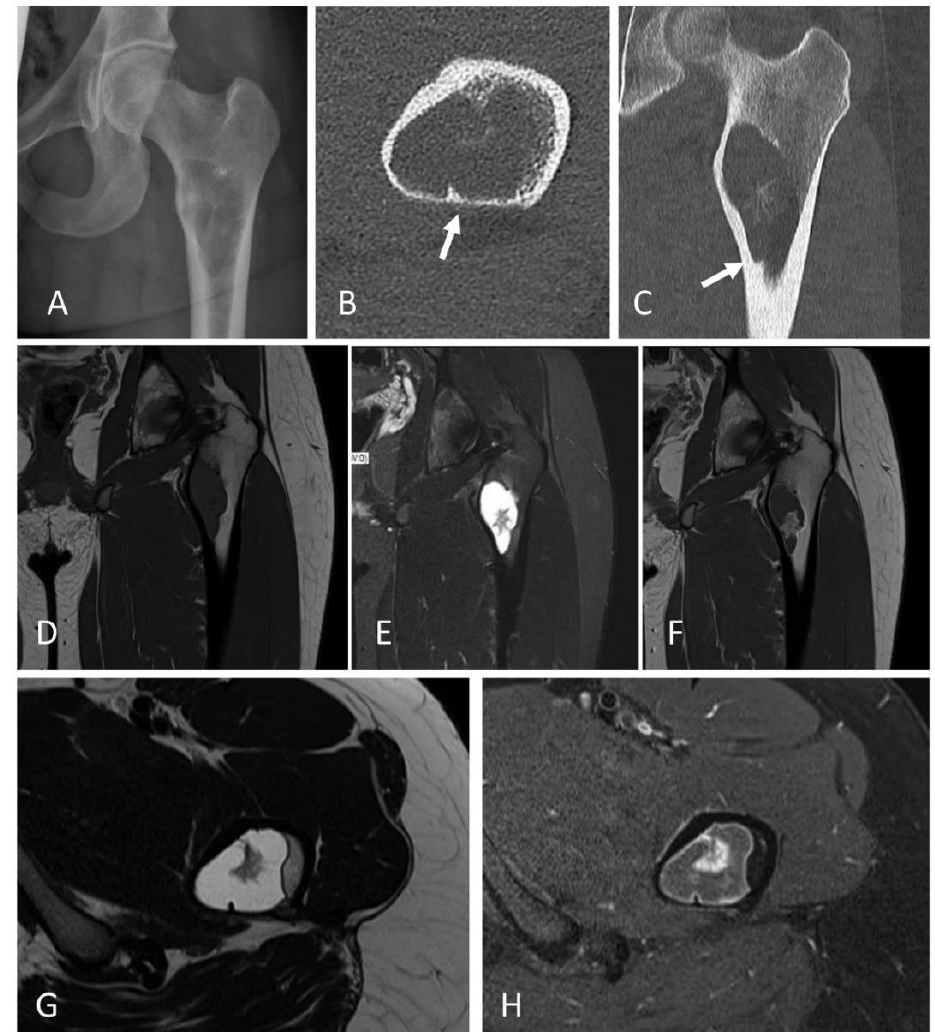
Figure 1. The 17-year-old boy with a lytic lesion of the proximal left femur (case #1) with a FUS::NFATC2 fusion. ( A ) AP-radiograph; ( B , C ) axial and coronal CT-reformatted images show a hypodense lesion with focal central calcifications, thinning of the cortex (white arrows), and intrale- sional subseptations; ( D – H ) MRI shows that the tumor T1-weighted images have intermediate signal ( D ) and high signal on T2-weighted images ( E , G ) with enhancement of the cyst wall and irregular central subseptations ( F , H ). No bone marrow edema or periosteal reaction are present. 2.3. EWSR1::NFATC2-Rearranged Soft Tissue Sarcoma (Case #4) A 69-year-old male patient complained of a slowly growing mass in the right lower leg. MRI showed a well-demarcated intramuscular lesion in the distal fibularis brevis muscle with peripheral contrast enhancement (Figure 6A–D). The tumor was resected with wide margins. Microscopically, the tumor was heterogeneous in appearance. In the hypocellular areas, it was composed of a myxohyaline or cartilaginous stroma-rich component that contained monomorphic ovoid to epithelioid tumor cells arranged in interconnecting cords and nests adjacent to a hypercellular component. The tumor cells in the hypercellular foci consisted of atypical spindle and round cells arranged in packed cords, nests, and solid sheets (Figure 6E–H). Focally, metaplastic bone was present. Mitotic activity was limited (<5 mitosis/10 HPF), and areas of necrosis were not present. Immunohistochem- istry showed cytoplasmic and membranous staining with CD99, and EMA was focally positive. NGS revealed EWSR1::NFATC2 fusion (Figure 3C). FISH showed break apart